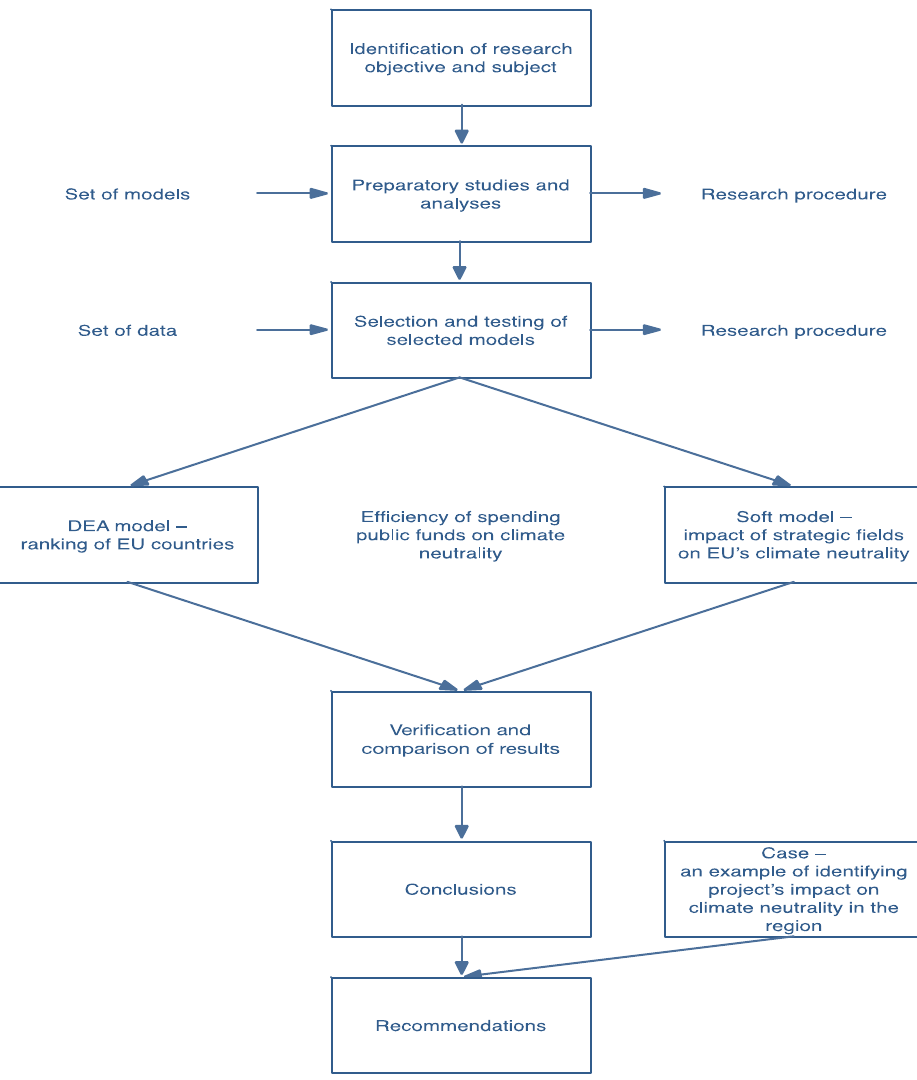
Figure 1. Flow chart of the article’s development process. Source: own elaboration. Statistical analysis required the usage of Microsoft Office Excel 2019 program (Red- mont, United States of America) and StatSoft Polska Sp. z o.o. STATISTICA package (Krakow, Poland); soft modeling required the implementation of specialized PLS software by J. Rogowski (Bialystok, Poland); and the DEA method required the use of Timberlake Consultants Limited STATA 16.1, serial number 401609215490 (Richmond upon Thames, UK). The syntax of the dea command can be found in Appendix